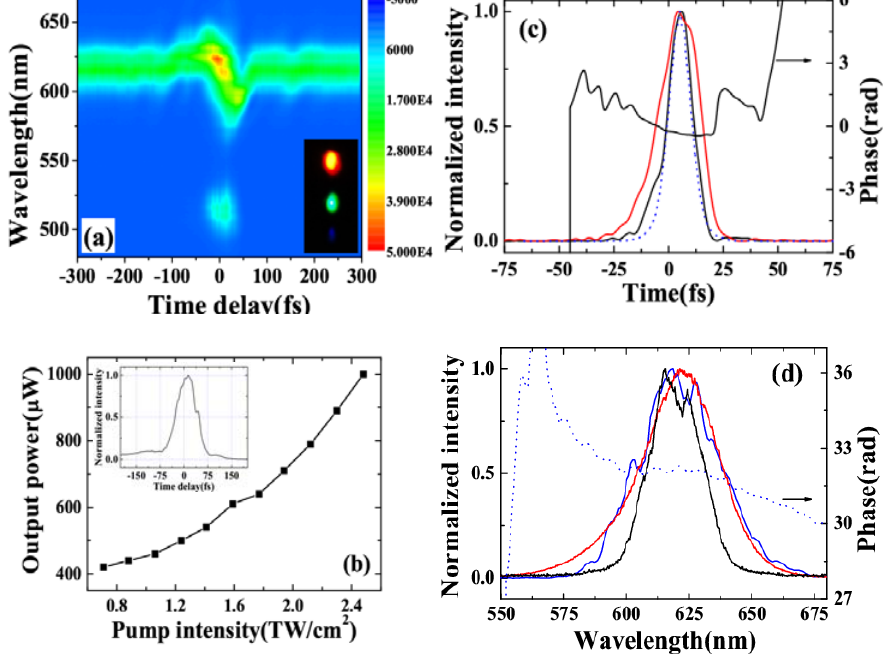
Figure 34. (a) The spectral profile and intensity of the output seed beam (AS3) as a when the crossing angle α was 2.80º ± 0.05º. (b) The function of the delay time t ps dependence of the output energy of the output seed pulse on the pump intensity. The inset shows the temporal profile of pump pulse. (c) The retrieved temporal profiles of the incident seed pulse (red solid line) and the compressed output seed pulse (black solid line), and the transform-limited pulse of the broadened spectrum (blue dotted line). (d) The retrieved spectrum (blue solid line) and the spectral phase (blue dotted line) of the output seed pulse. The measured spectra of the incident seed pulse (black solid line) and output seed pulse (red solid line)